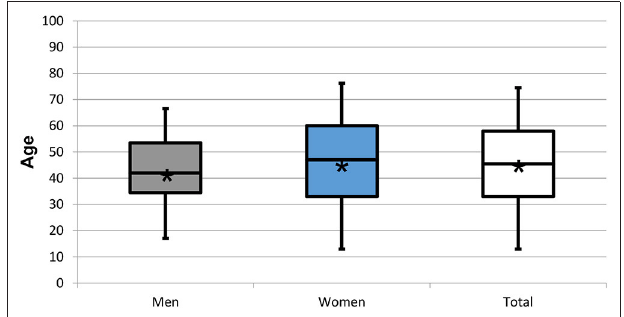
FIGURE 4 | Box plots representing the age distribution by gender of the 352 patients responding positively to the screening question on insomnia and/or hypersomnia. Star symbol (*) indicates mean.